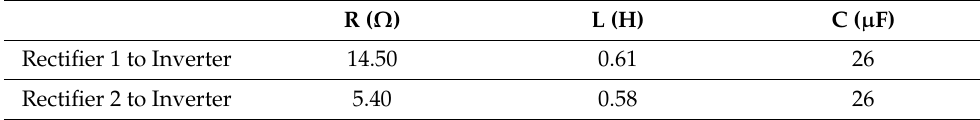
Table A6. MTDC transmission line (T-model)